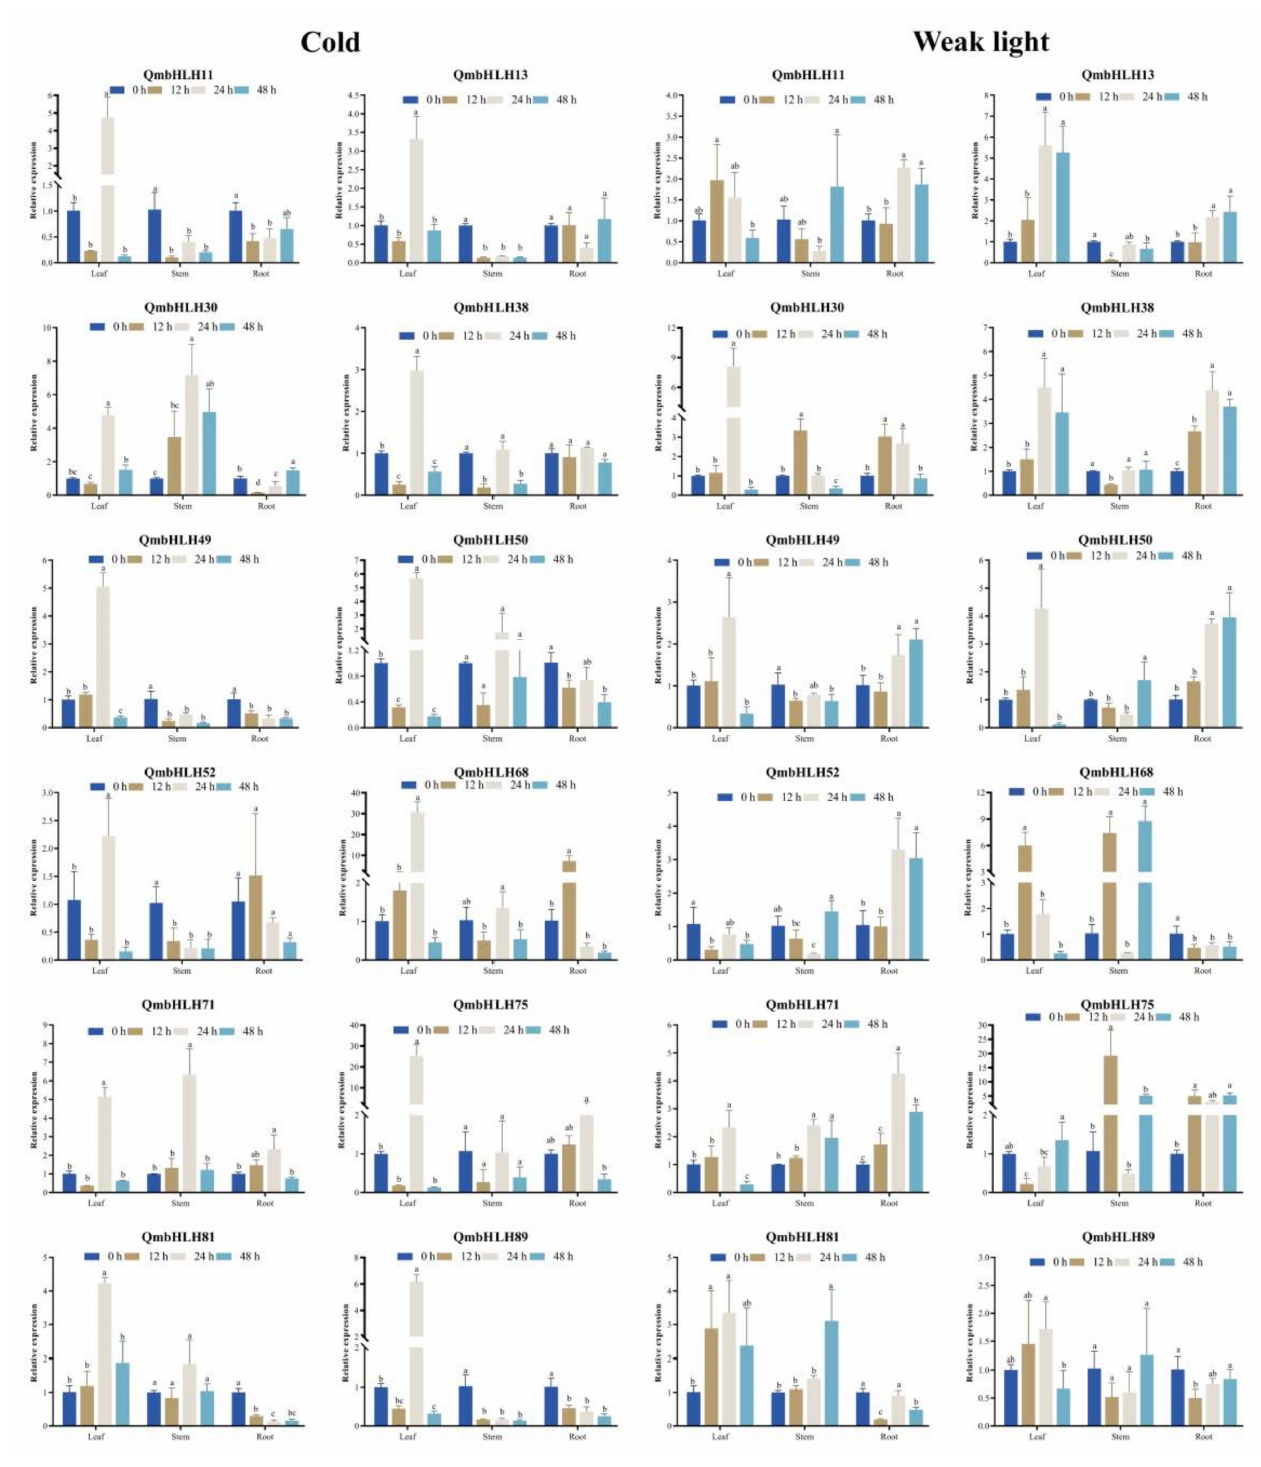
Figure 9. Expression patterns of 12 QmbHLH genes in leaf, stem, and root tissues under cold and weak light treatments via qRT-PCR. Different letters in each treatment indicate significant differences in QmbHLH gene expression ( p < 0.05, Duncan’s